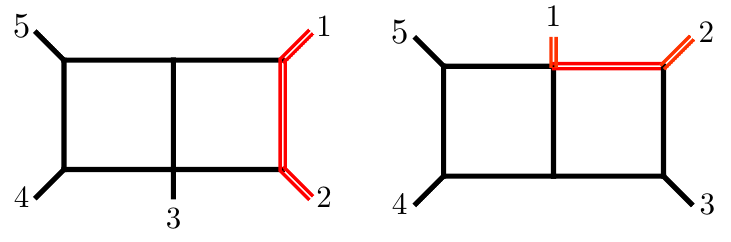
Figure 5 . The two five-point double-box topologies, containing the canonical MIs I 4 , I 5 , I 6 , I 7 , and I , I 8 , I 9 10